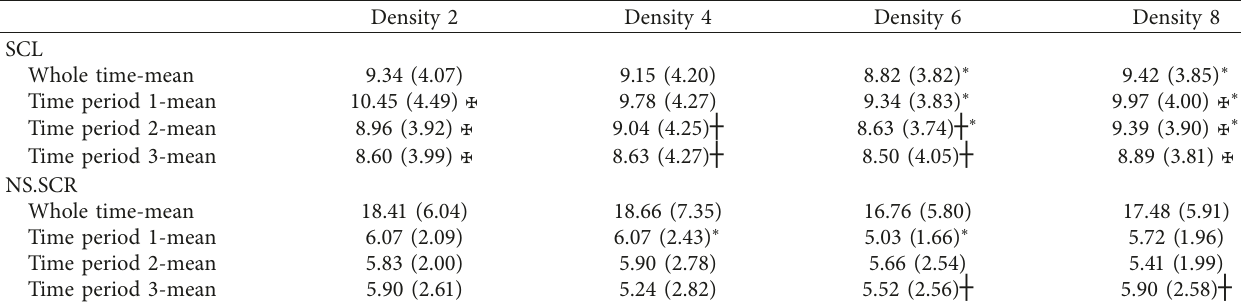
Table 3: Mean parameters SCL and NS.SCR for the whole time and for different time